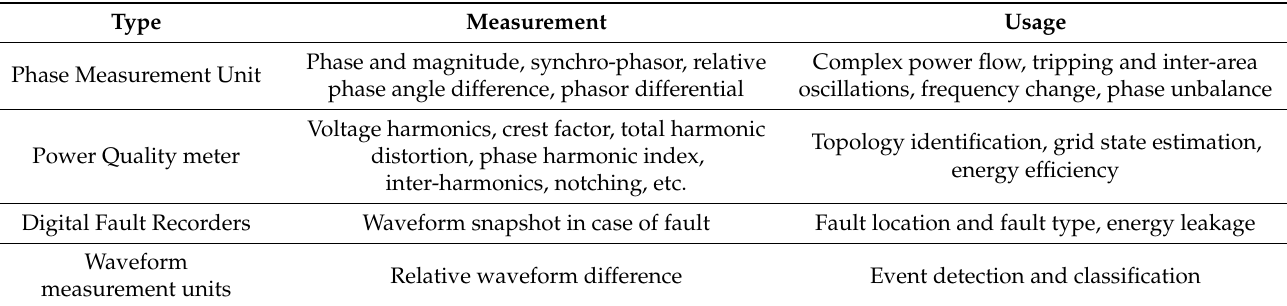
Table 6. Smart grid measurements.